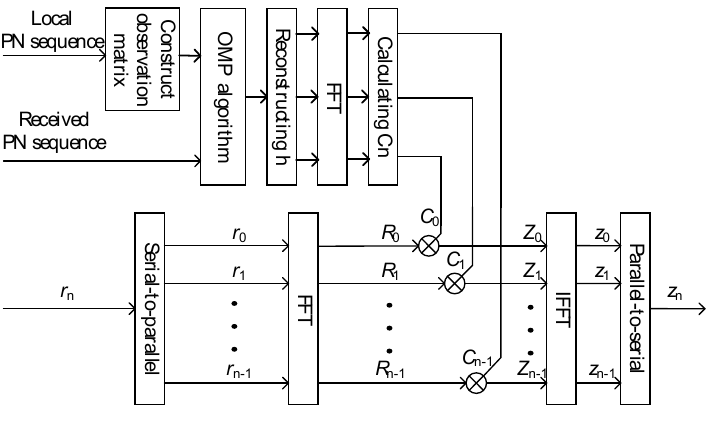
Figure 5. Channel estimation and equalization process.